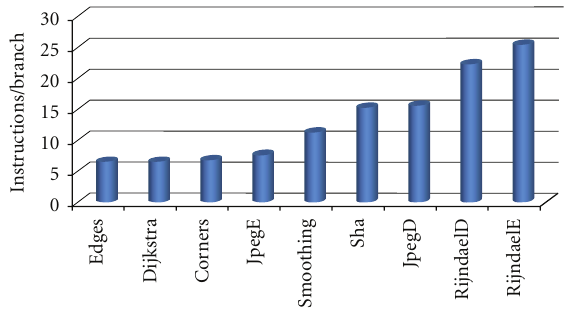
Figure 13: Average of number of instructions executed per branch— edges is the most control-flow application and rijndaelE is the most data-flow